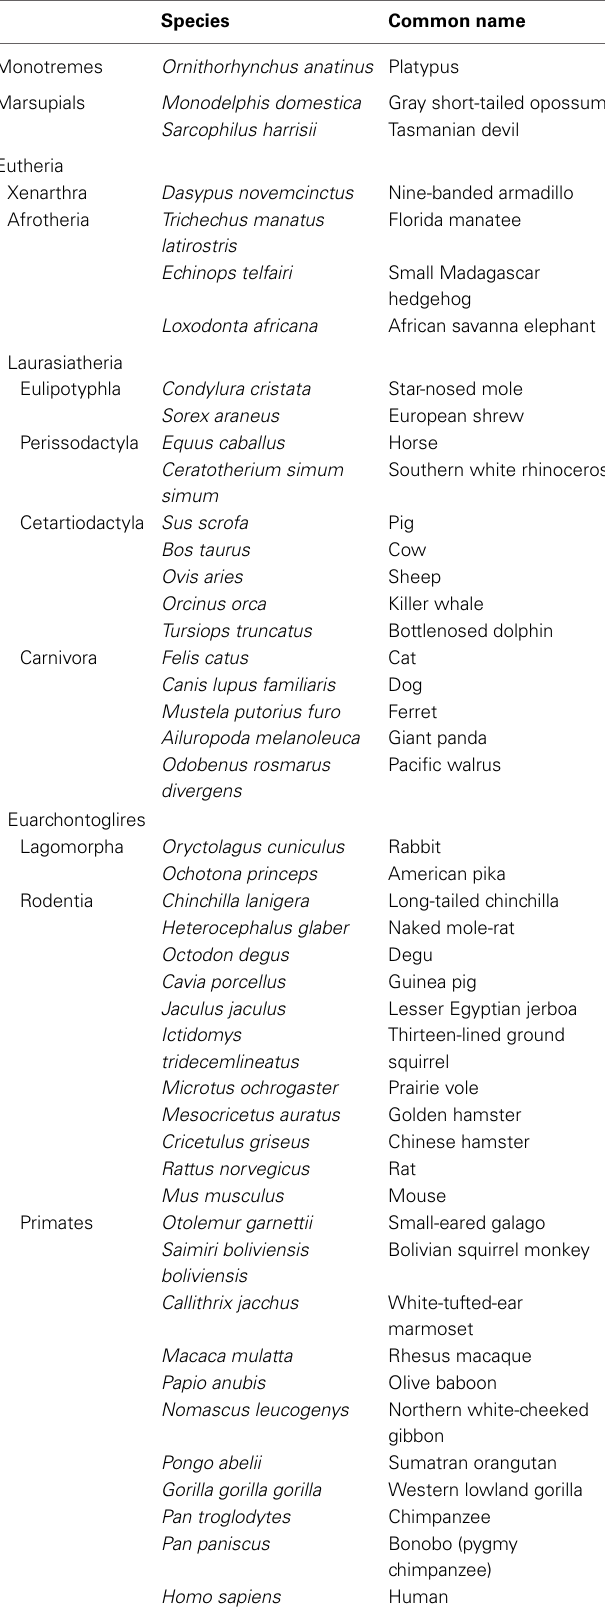
Table 2 | Species used in the